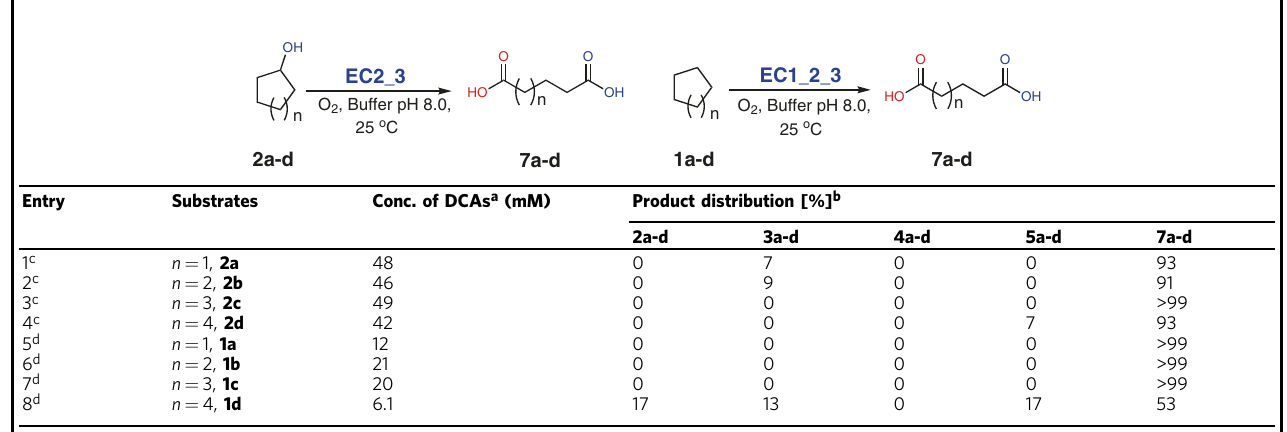
a Determined by gas chromatography. b Relative amounts based on the concentrations of dicarboxylic acids 7a-d and analyzed by gas chromatography. Data are presented as mean value of two biological replicates. Source data are provided as a Source Data fi le. c Reactionswereconductedwithindicatedsubstrates(50mM)in4mLcellsuspensionsat16gCDWL − 1 .EC2_3containing E.coli (M2E)and E.coli (M3B_M3E)ataratioof 2:1wasin200mMKPbuffer (pH 8.0) at 25°C and 200rpm for 24h.